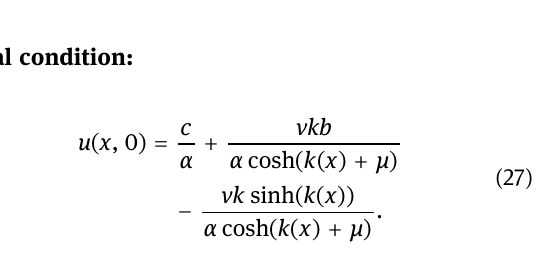
Figure 1: Solutions for = N 51 , = ν 10 −2 , = t Δ 0.00001 .